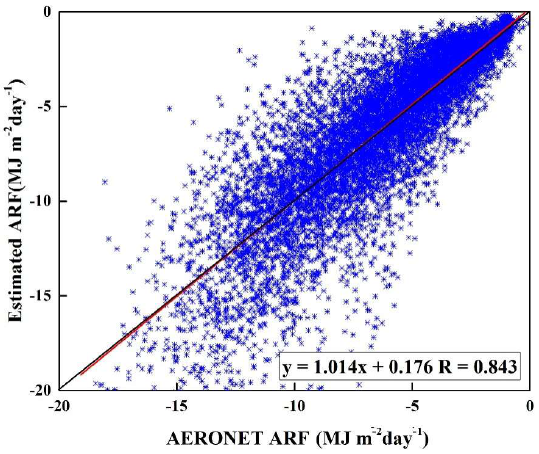
Figure 12. Validation of estimated ARFB at AERONET stations during 2002–2014.